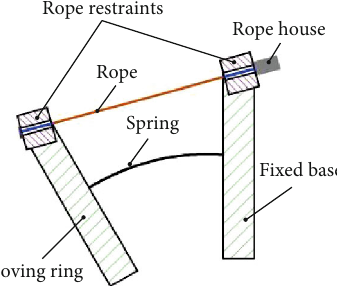
Figure 7: Schematic diagram of the movement with the cable restraint